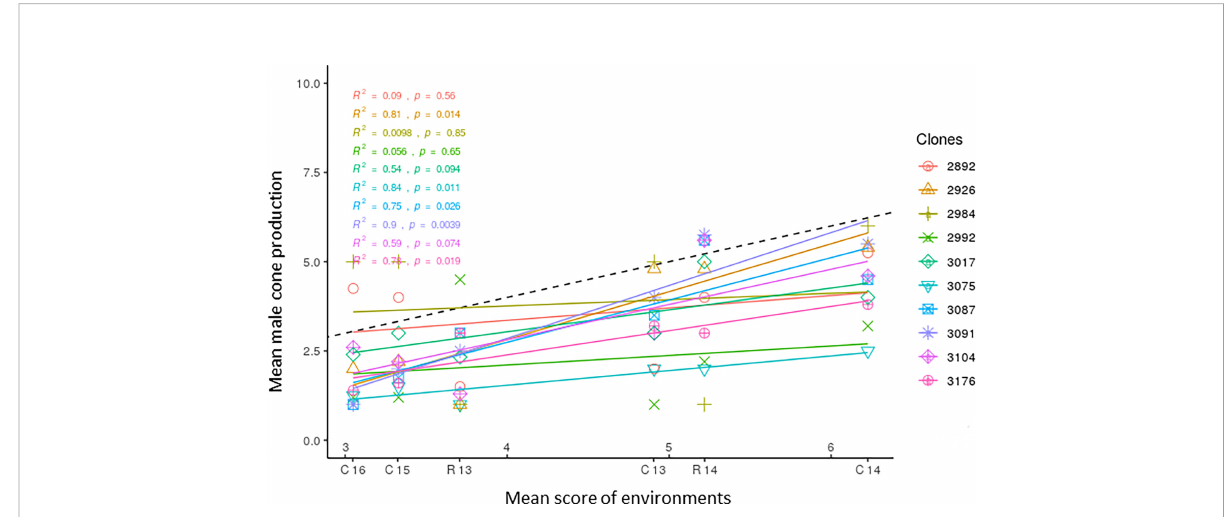
FIGURE 4 Clonal means of the ten C. sempervirens clones showing the lowest production of male cones are plotted against mean scores of the six environments (C13, C14, C15, C16, R13, R14), reporting the corresponding regression lines. R 2 values and signi fi cance level are reported for all regressions. C13, Cannara 2013; C14, Cannara 2014; C15, Cannara 2015; C16, Cannara 2016; R13, Roselle 2013; R14, Roselle